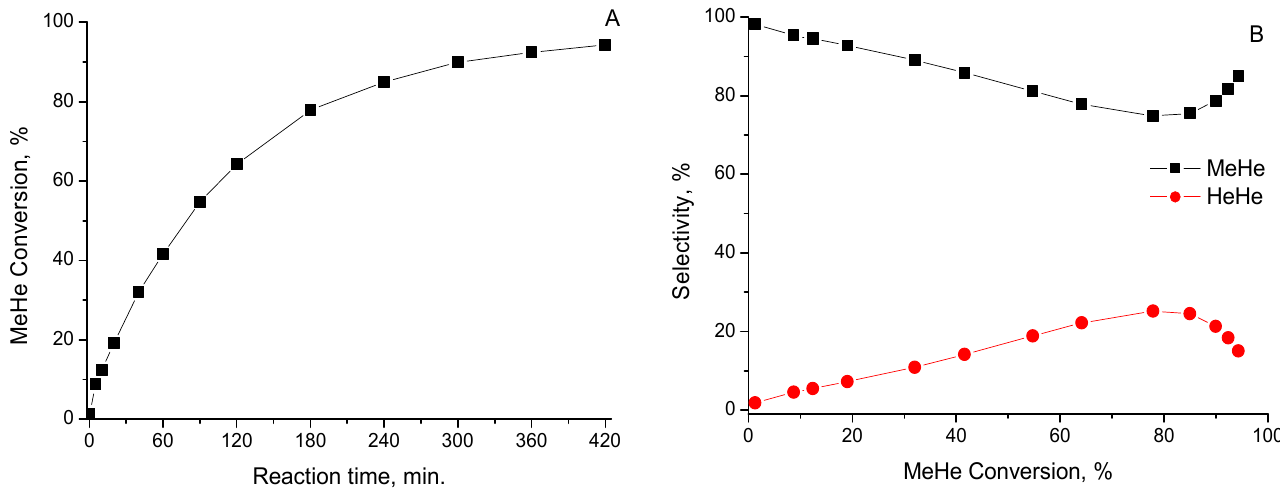
Figure 8. MeHe conversion ( A ) and selectivity to reaction products ( B ) observed in a long-time experiment on 1CuZn-R catalyst. The amount of MeHe—0.69 mol, m cat = 3.0 g, T reac. = 210 °C, p H2 = 100 bar.